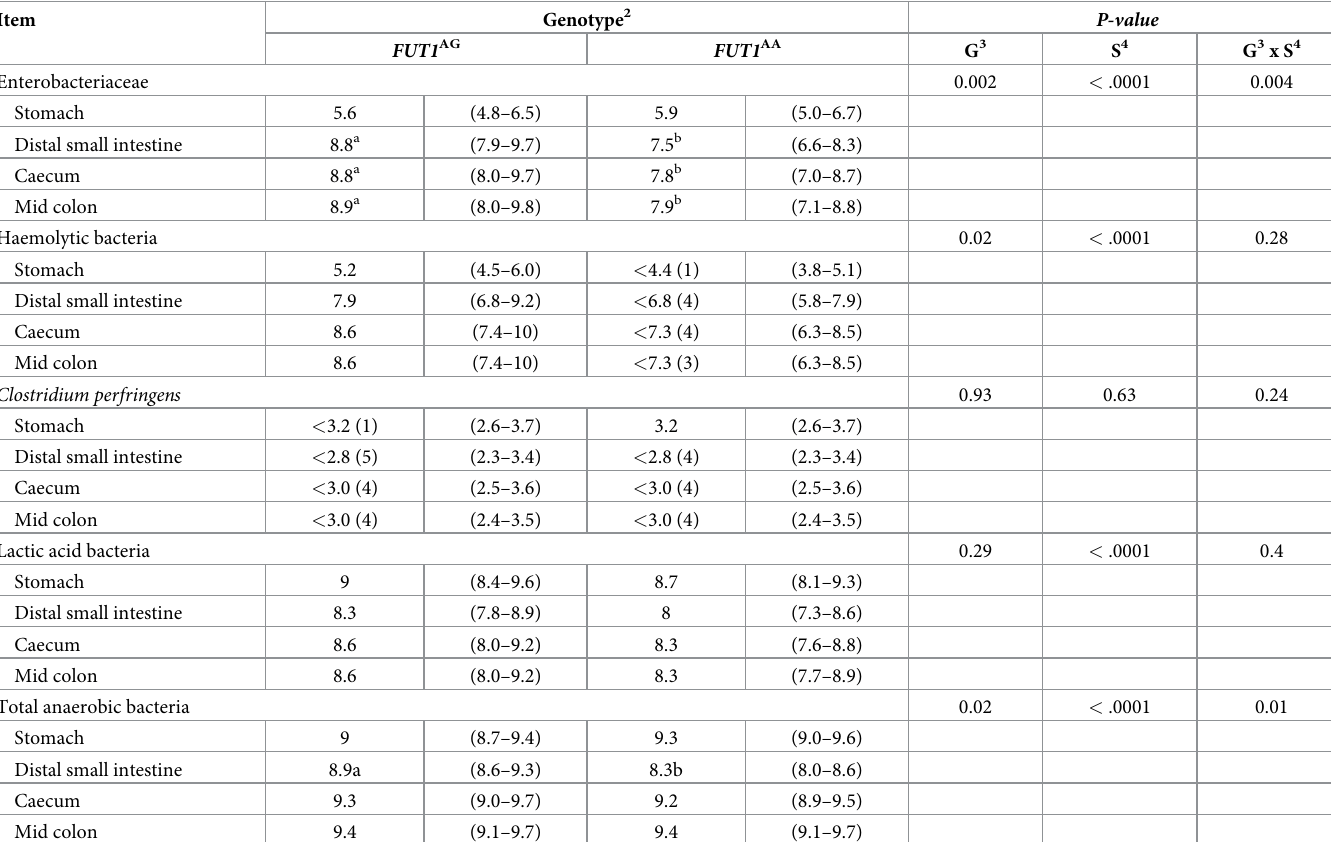
Table 4. Enumeration (log cfu/g sample) of selected microbial groups in digesta from the gastrointestinal tract of 34 days old piglets (one week post-weaning) 1 from the FUT1 AG and FUT1 AA